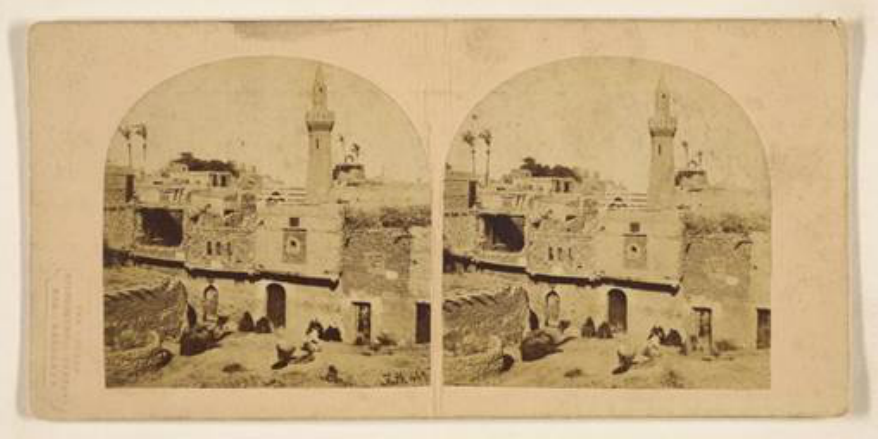
Figure 4. View at Boulac. The Port of Cairo, stereocard, 1856–7, Francis Frith (Source: The J. Paul Getty Museum, https://www.getty.edu/art/collection/object/107057)